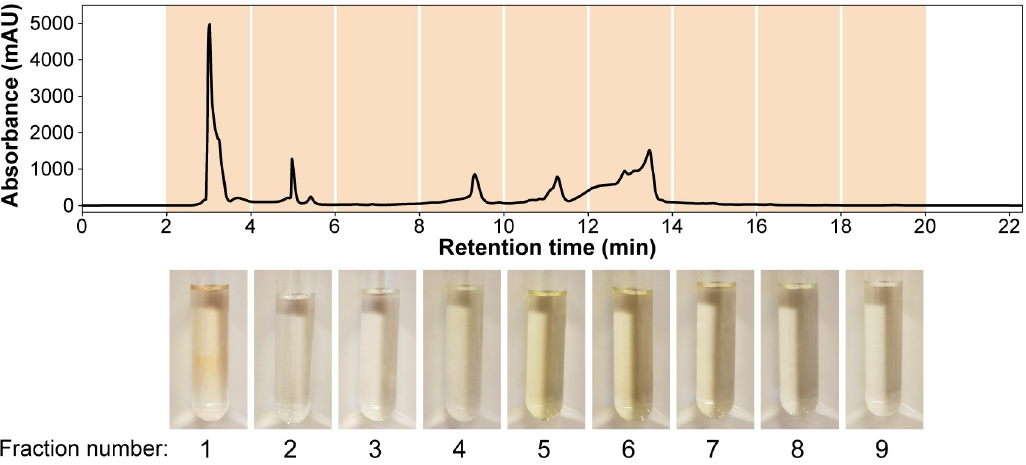
Fig 3. Semi-preparative HPLC fractionation of rocket salad juice. The juice was extracted in 50% methanol and the separation was monitored at 214 nm. Photographs at the bottom show the nine collected fractions.